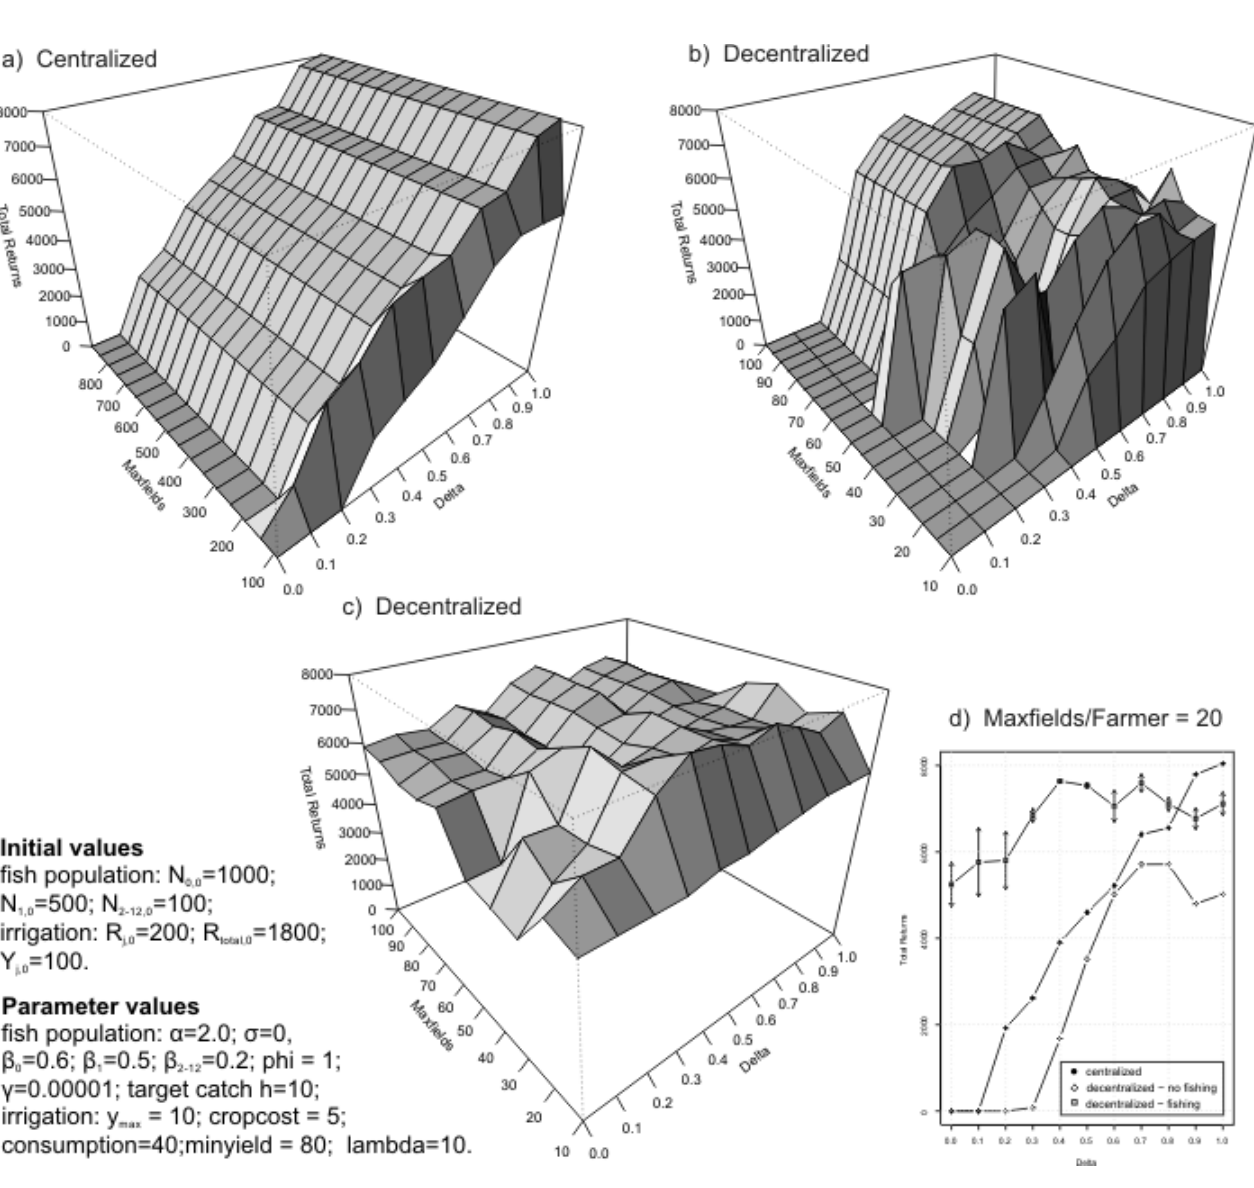
Fig. 7. Total accumulated global returns at the end of the simulation period (yr 200) with change in the maximum total number of fields (centralized) or maximum number of fields/farmer (decentralized) for the a) centralized and b) decentralized models without fishing, and c) decentralized with fishing. D) Comparison of the total accumulated global returns at the end of the simulation period of the centralized, decentralized without fishing and decentralized with fishing for a run with maximum number of fields/ farmer =